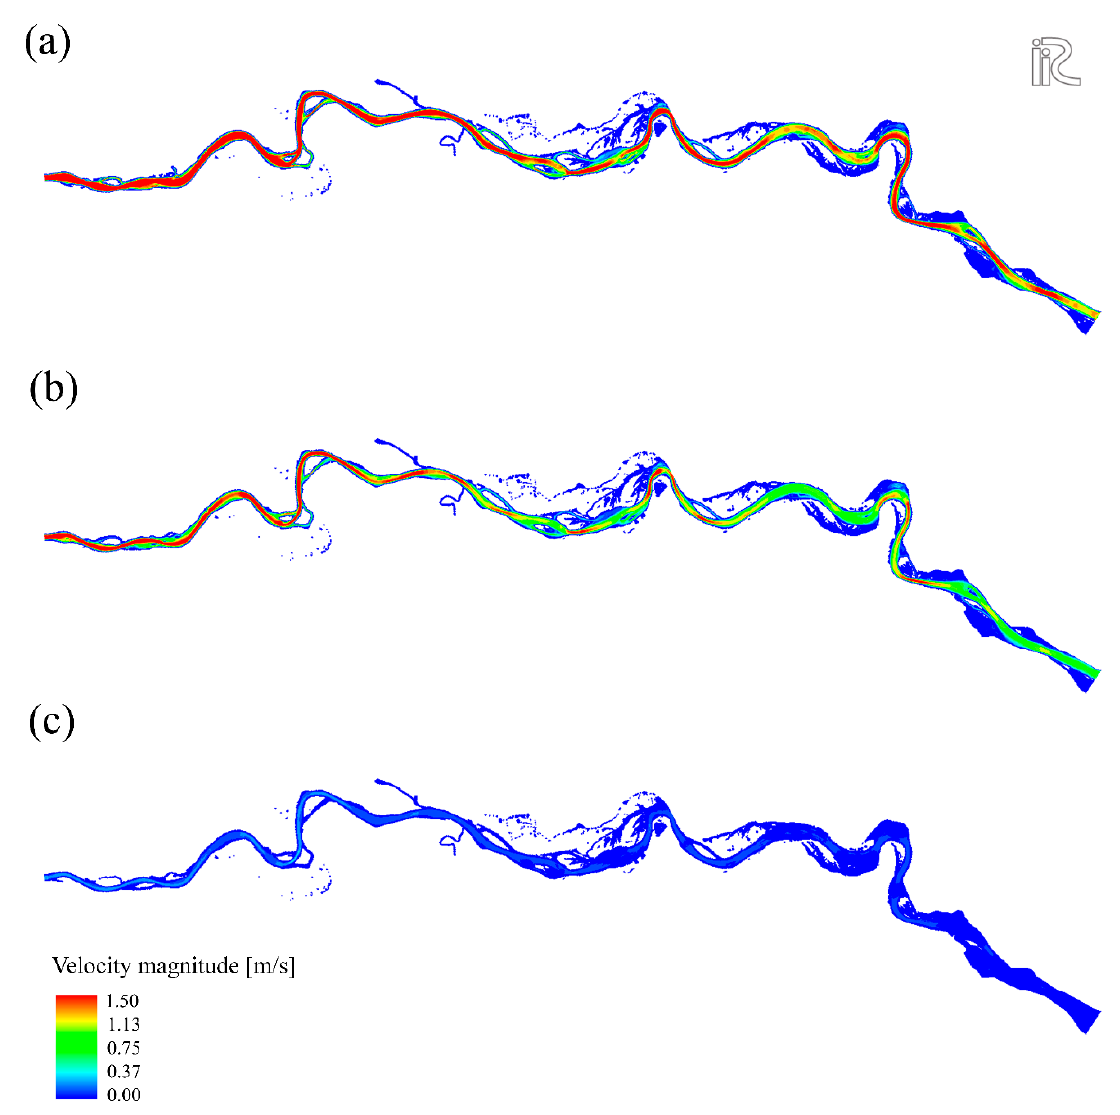
3 /s, ( b ) 3000 m 3 /s, ( c ) 200 m 3